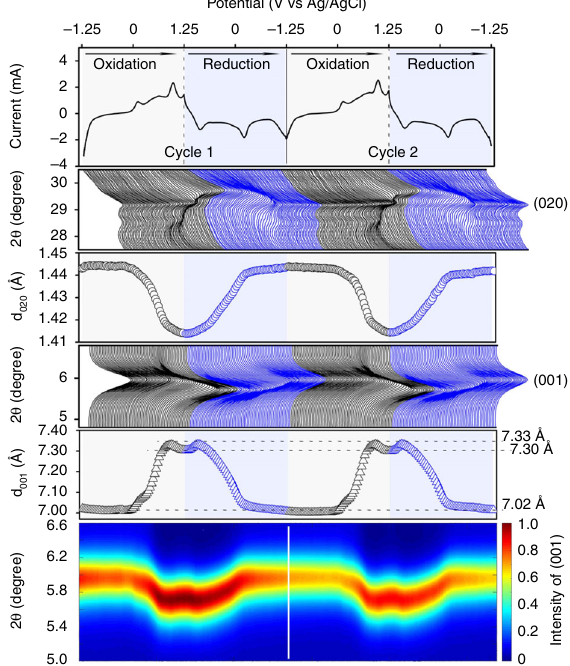
Fig. 5 In situ XRD characterization of Na 0.27 MnO 2 . Two CV scans were conducted between − 1.25 V and 1.25 V at a scan rate of 0.75 mV s − 1 , showing the changes of d-spacing for (001) basal diffraction plane and (020) Bragg diffraction plane and the contour plot peak variation of (001) plane during the charging (black) and discharging (blue)